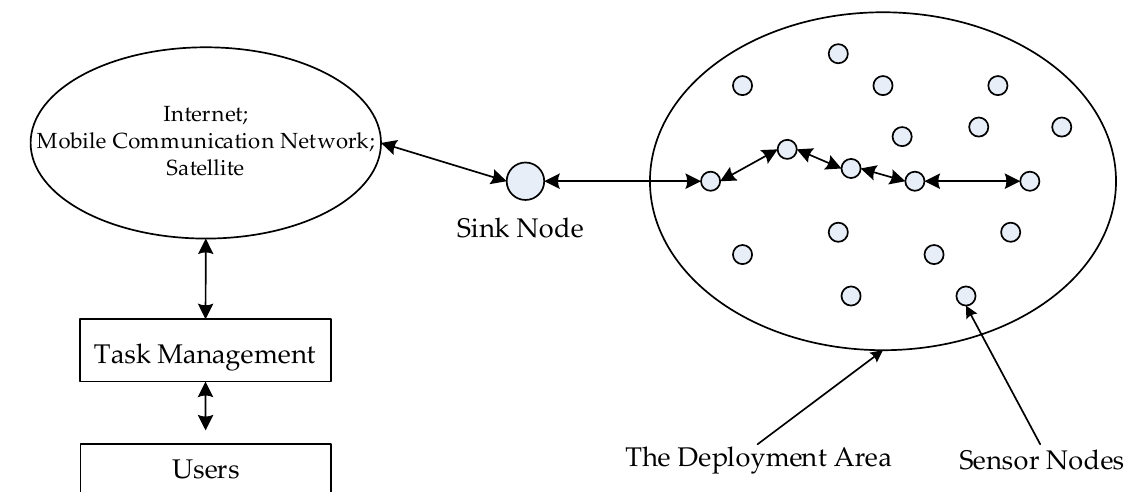
Figure 1. Wireless sensor network structure diagram.